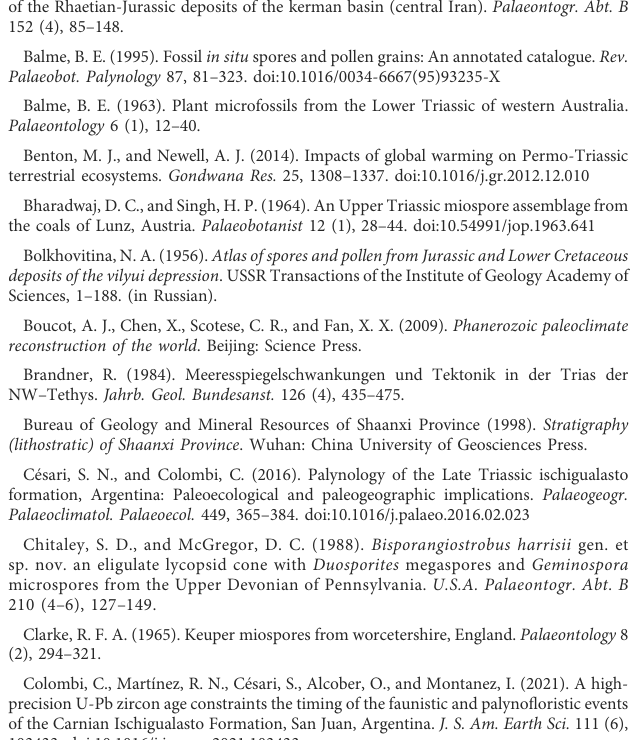
SUPPLEMENTARY APPENDIX S1 Stratigraphy of the Yunmeng pro fi le showing isotopic dating and productive palynological samples. Results of the quantitative sporo-pollen analysis (number). SUPPLEMENTARY APPENDIX S2 Description of the species in the Yunmeng Pro fi